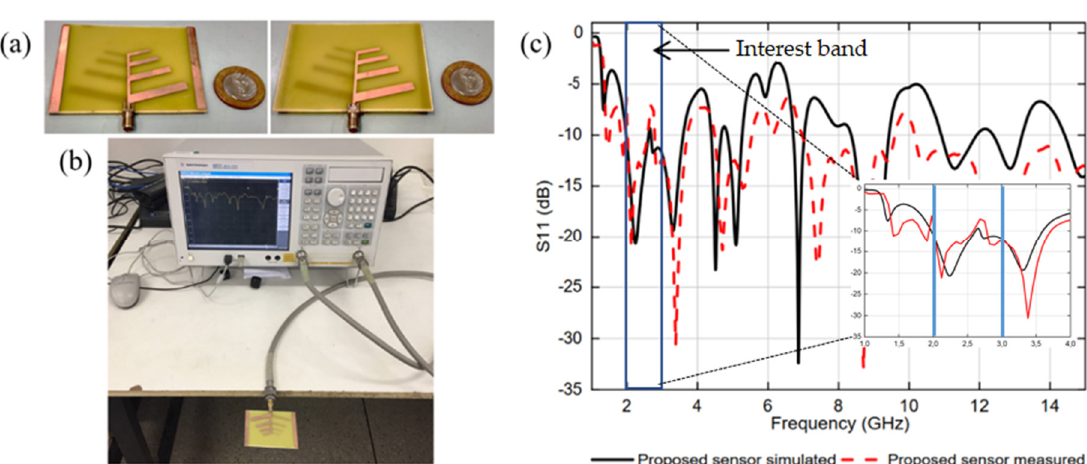
Figure 4. Photos of the ( a ) proposed antenna sensor prototype, top view (left side) and bottom view (right side), and ( b ) measurement setup. ( c ) Reflection coefficient simulation and measurement frequency responses.